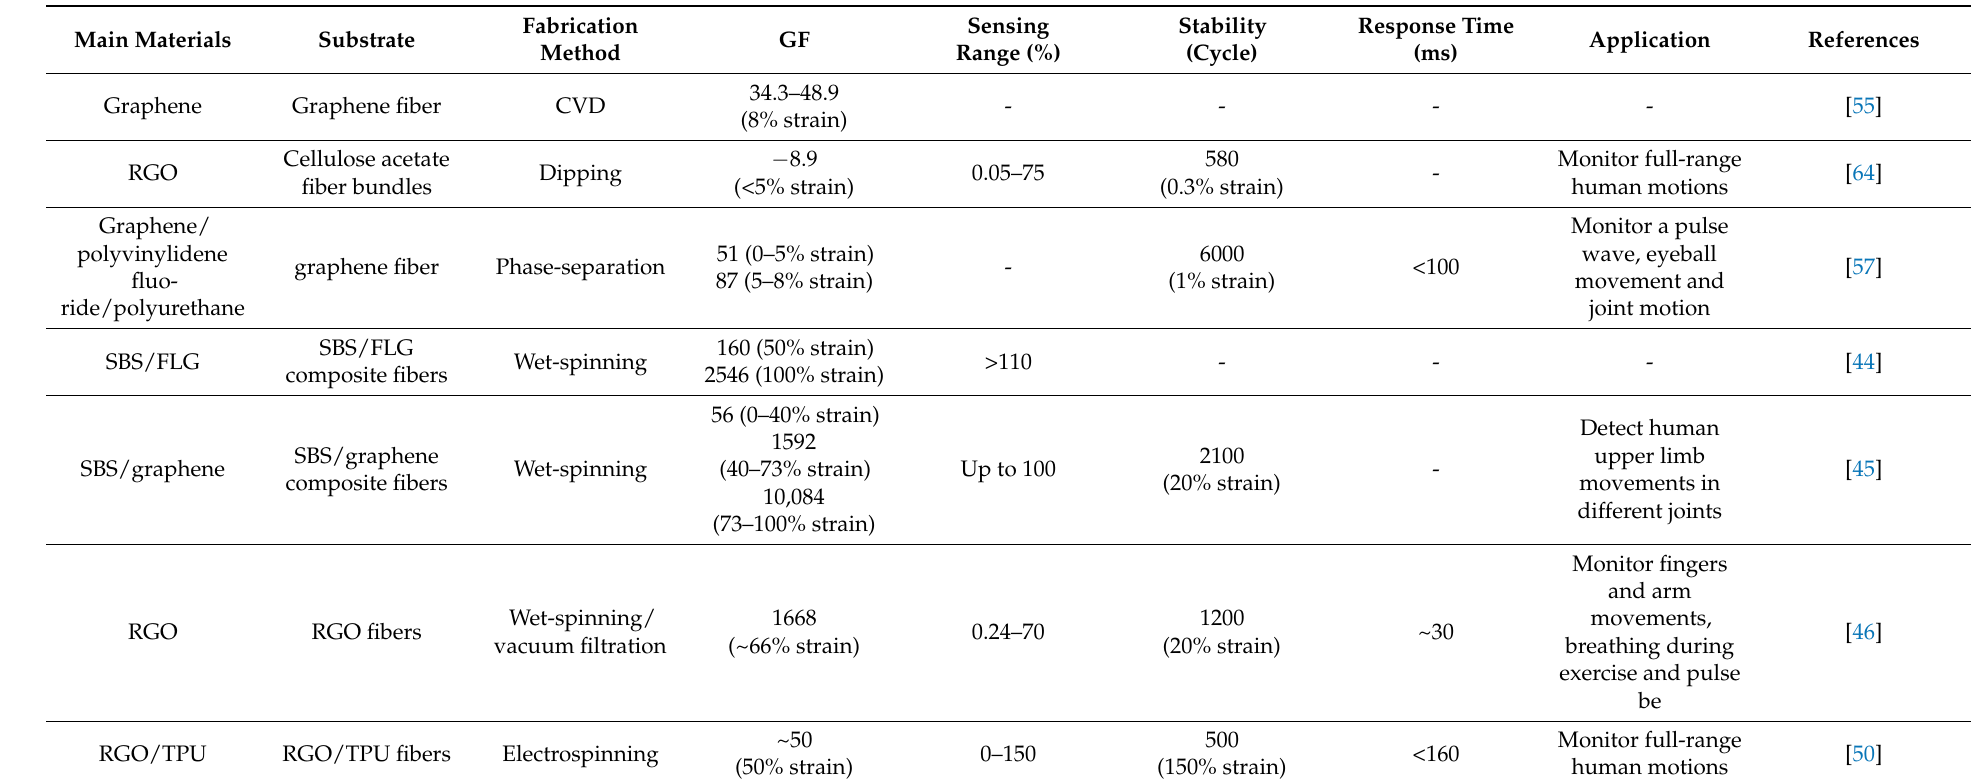
Table 1. Properties of various graphene-based staple fiber strain